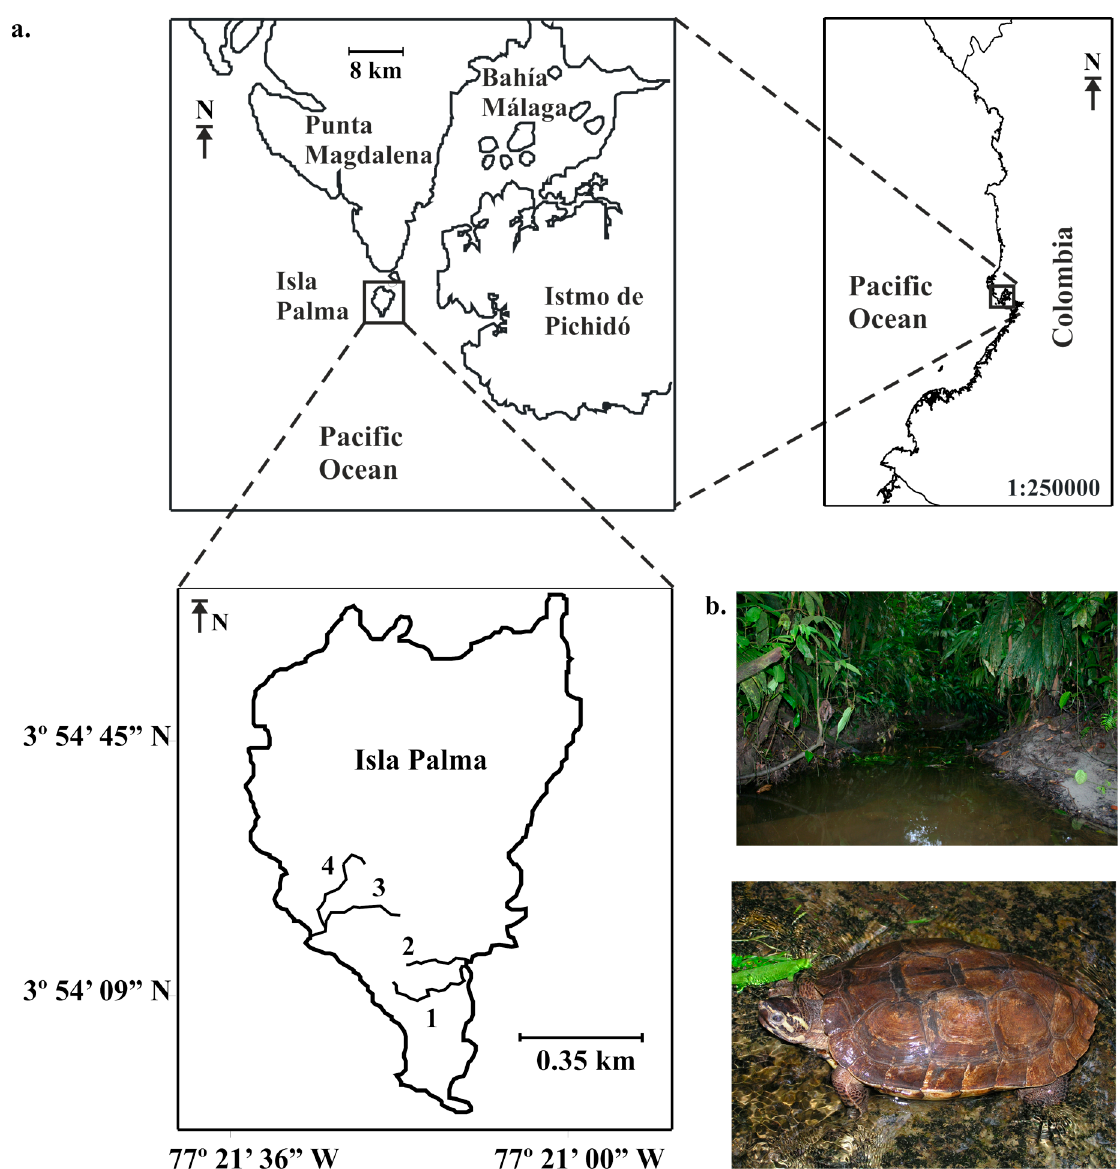
Figure 1. ( a ) Map showing the location of Isla Palma along the Colombian Pacific and the four study streams on the island, ( b ) photos of an island stream and an adult female Rhinoclemmys nasuta (photos by the authors).